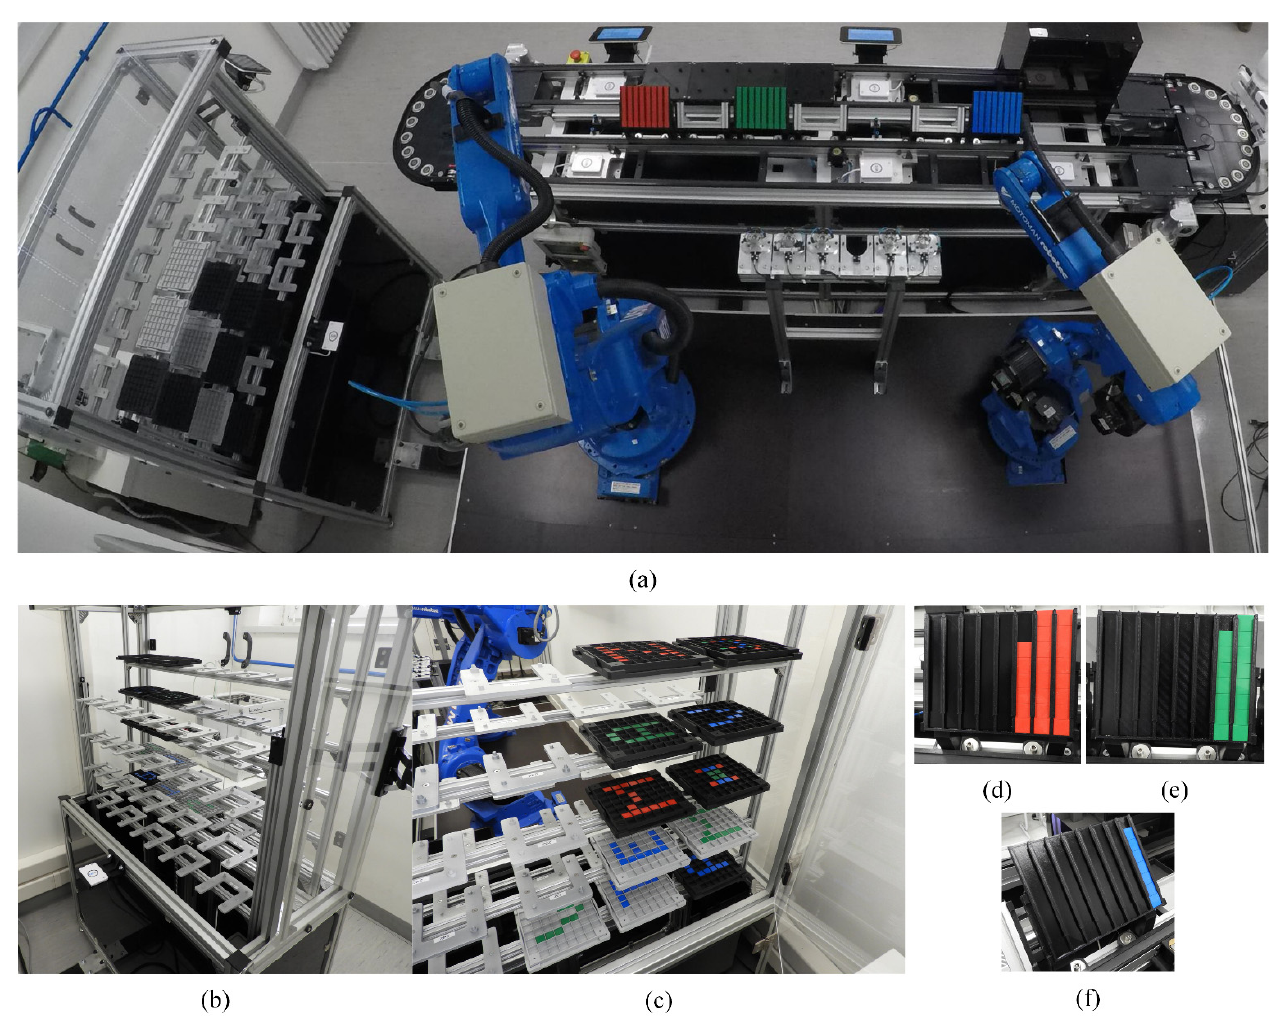
Figure 16. The figure shows: ( a ) the state of the assembly system before the start of assembly with full WBPFP and buffers; ( b ) no base parts in the first row of the WBPFP after assembling; ( c ) finished products in the warehouse in the second row; ( d ) the state of the buffer with red tiles, ( e ) green tiles, and ( f ) blue tiles after the completion if the assembly process.